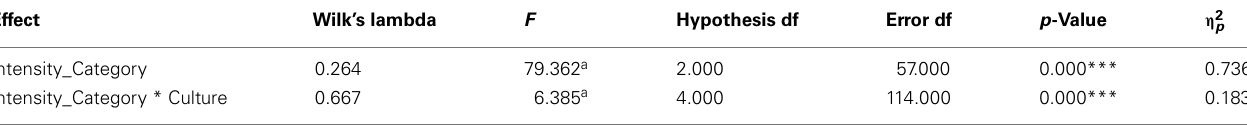
TableA6 | Omnibus MANOVA for intensity difference scores of ipsatized